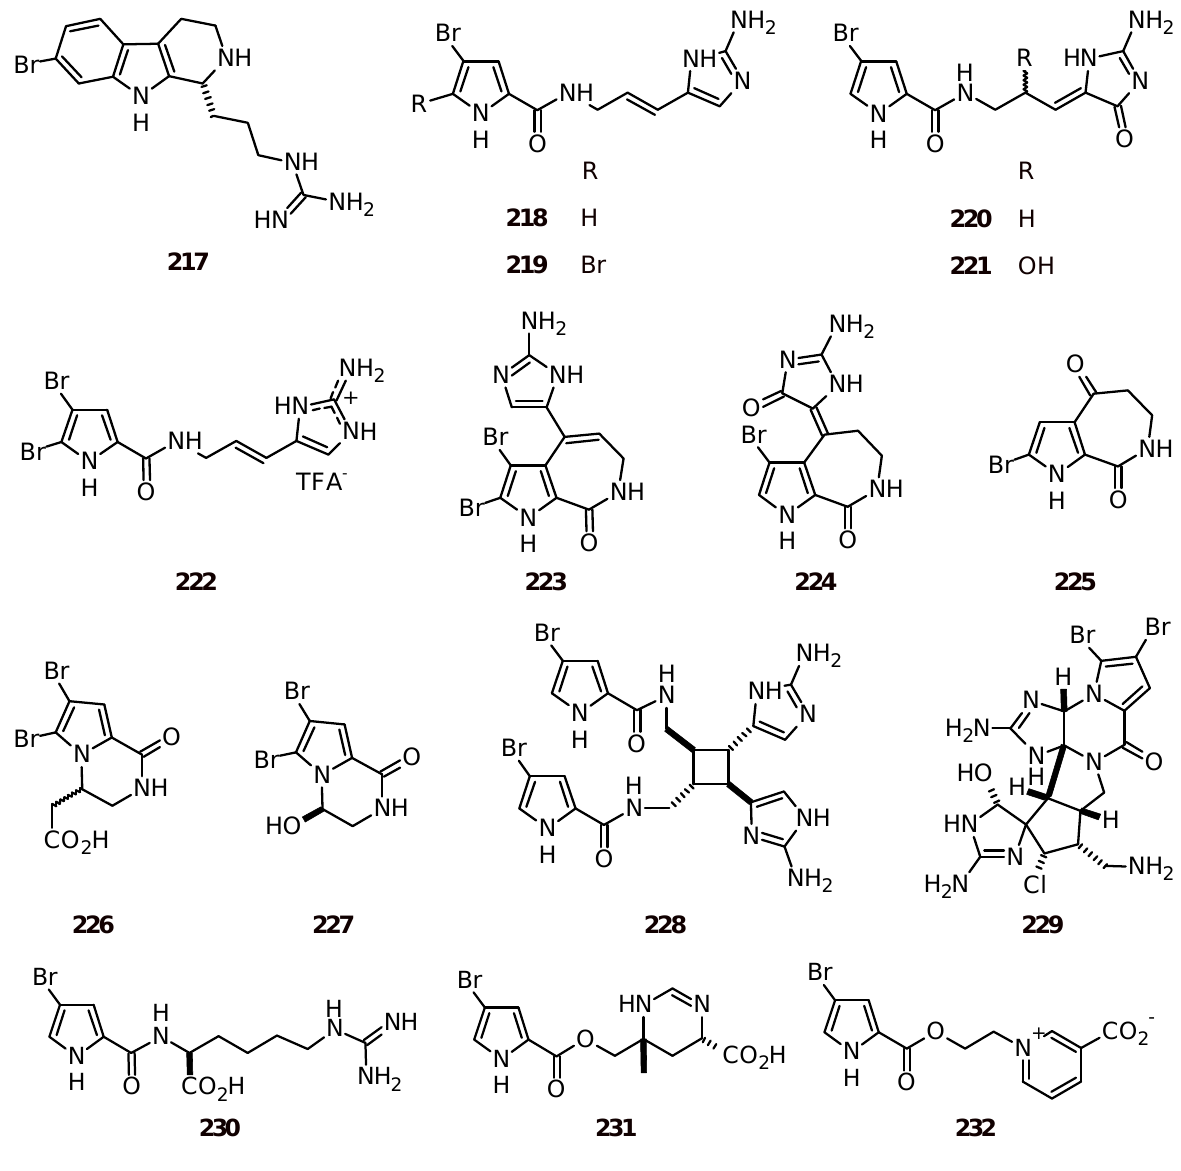
Figure 25. Structures of β -carboline and b romopyrrole alkaloids 217 - 232